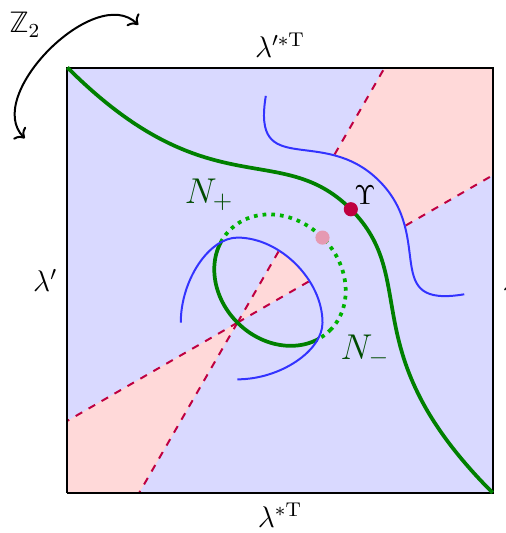
Figure 8. The configuration relevant for the partition function Z ing f M 2 k by Z k , we get the manifold c M 2 k = f M 2 k / Z k shown here, with a conical defect at Υ of opening angle 2 π/k . This manifold, and the fields on it, enjoy a remaining Z 2 symmetry that com- plex conjugates all the fields, and reflects them across the gravitational region in the way shown. This symmetry fixes a surface N + ∪ N − , which goes through Υ and meets the boundary of the asymptotic